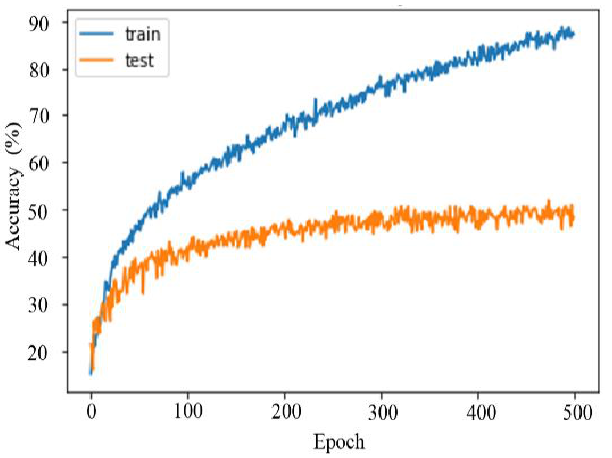
Figure 8. The train and test accuracy of 1-D CNN applying MFCC+pitch features (without S-LDA) eNTERFACE